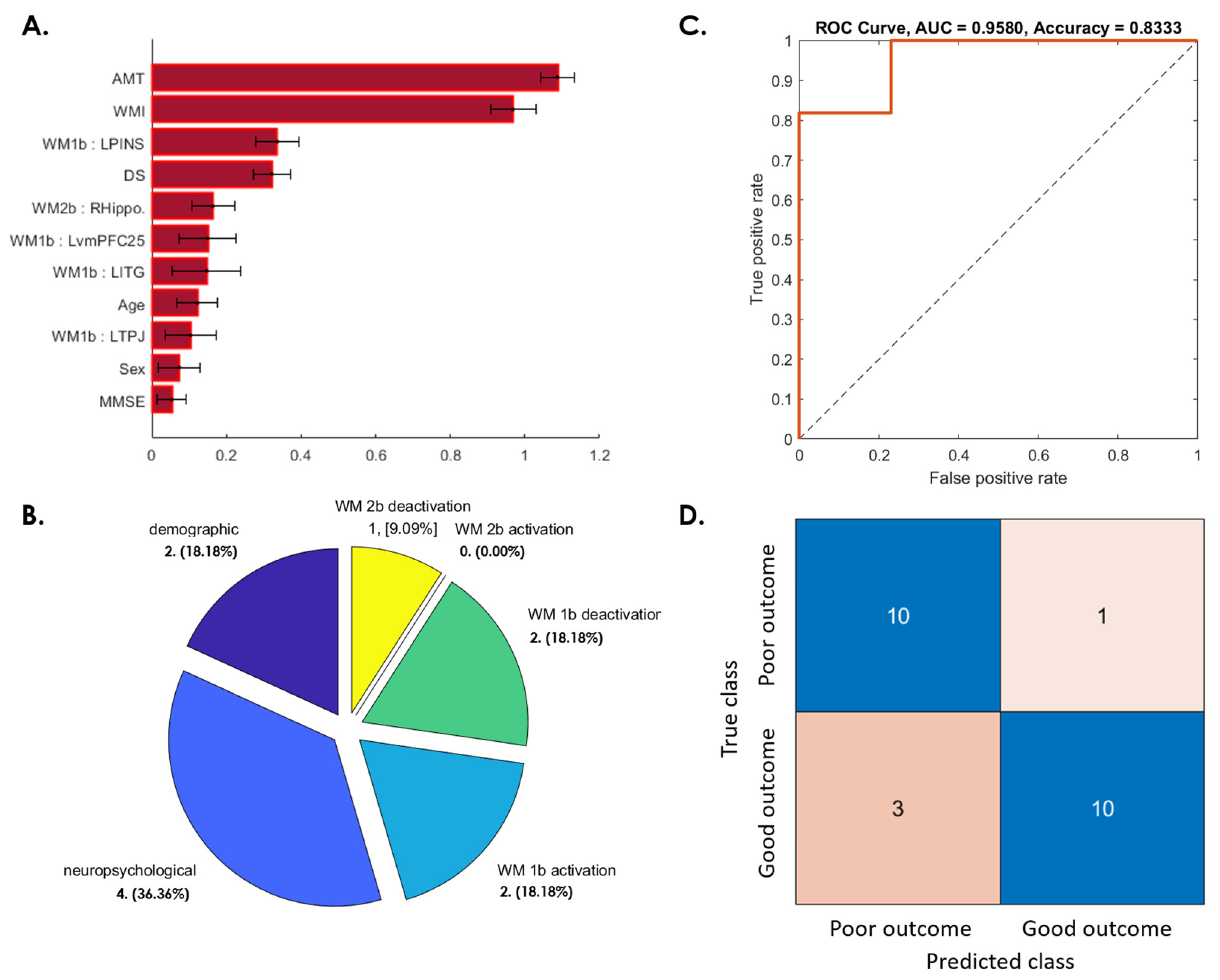
Figure 6. SVM predictive model for 45.83% of patients whose WM ability after 1 year became worse than at the baseline. ( A ) The red bar graph and the corresponding error bar, respectively, represent the average and standard deviation of the discriminative feature weights among the 10 cross-validated SVM classifiers. ( B ) Profiles of the selected features for constructing the SVM classification model. None of the WM 2-back activation features were selected for this predictive model. ( C ) ROC curve of the selected feature to discriminate the “poor outcome group” from the “good outcome group”. ( D ) Confusion matrix to summarize the results of this binary classification